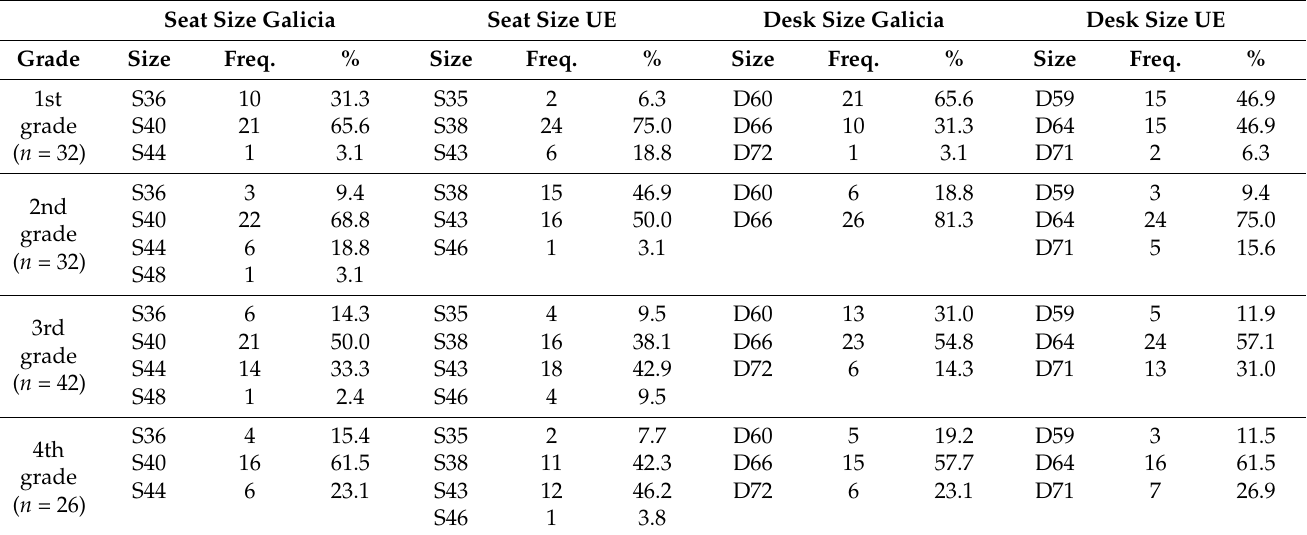
Table 4. Proposed furniture assignment according to the EU and Galician